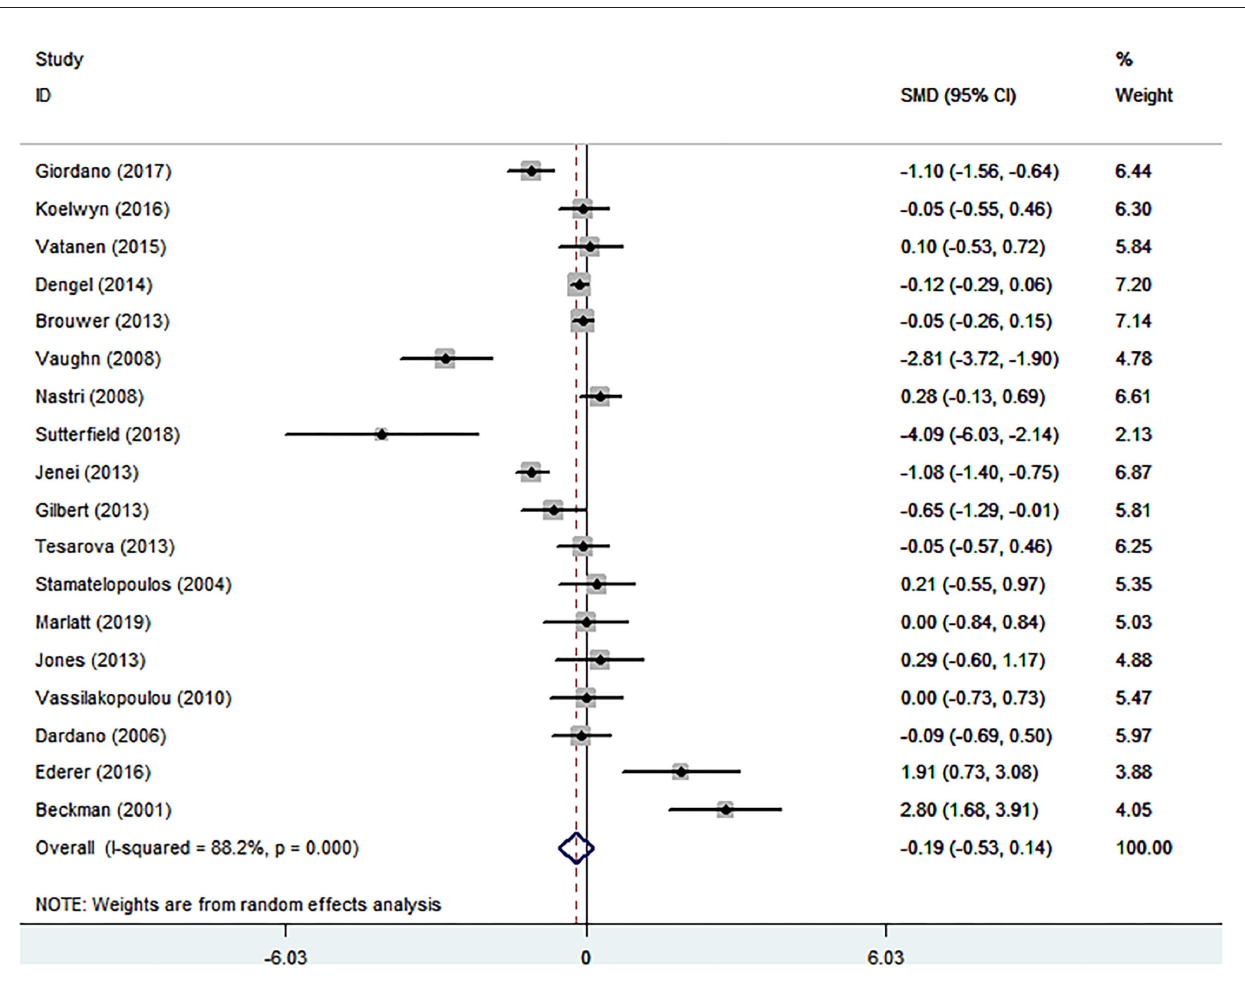
FIGURE 4 | Forest plot of flow-mediated vasodilation in patients with cancer and controls without cancer. SMD, standard mean difference; CI, confidence